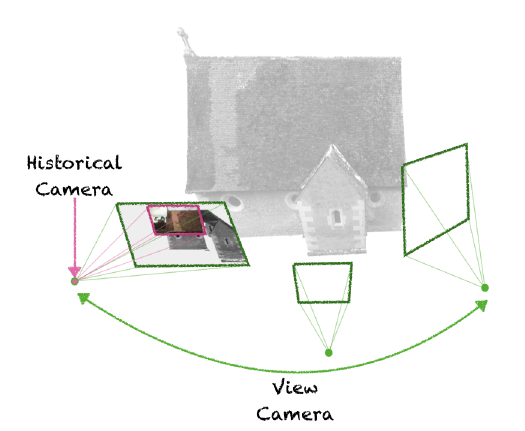
Figure 2. A historical camera has a fixed viewpoint, representing a snapshot of the photographed scene. A view camera is capable of changing its viewpoint, allowing it to navigate through the 3D